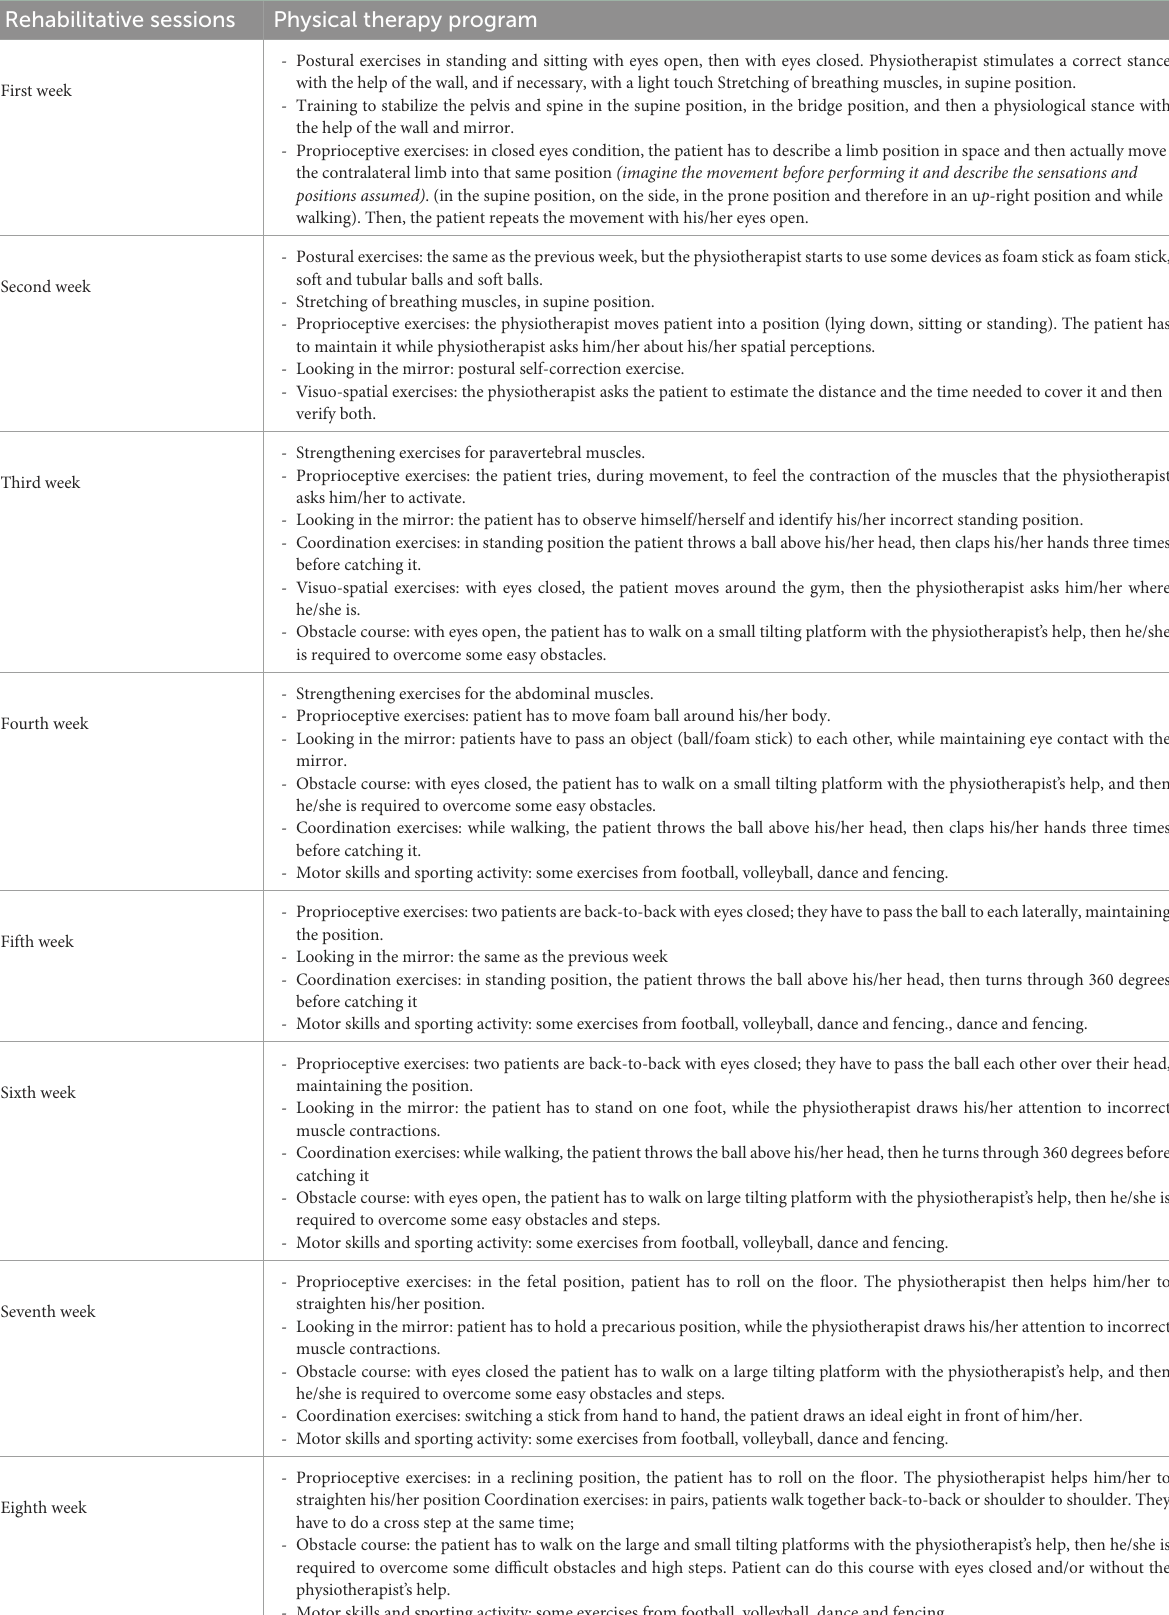
TABLE 1 Rehabilitation